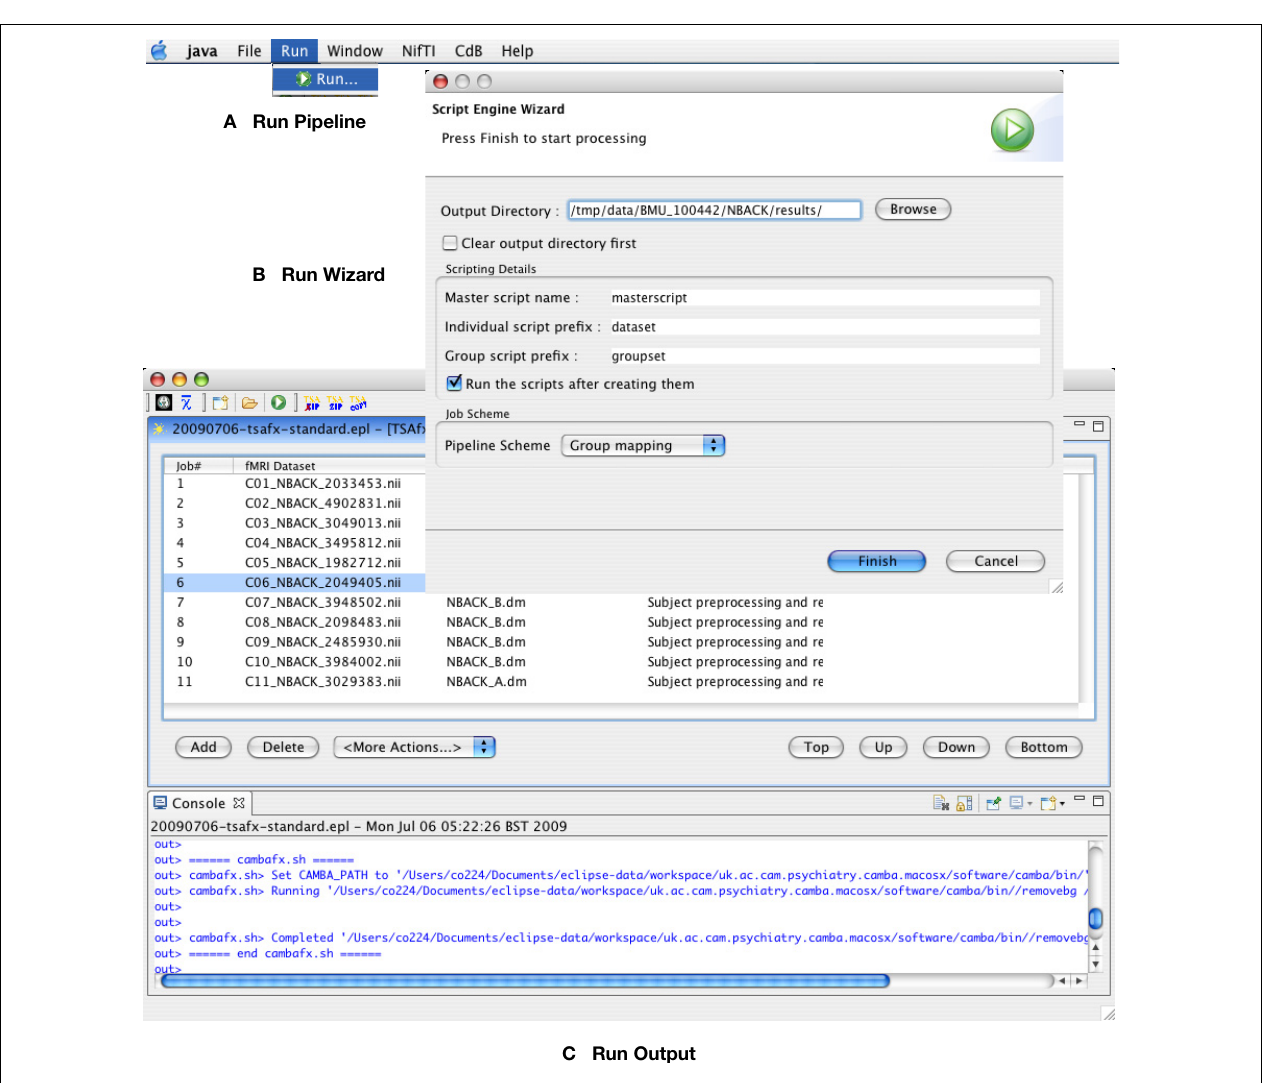
FIGURE 3 | Steps in operation by consumers to run the workfl ow. See text for